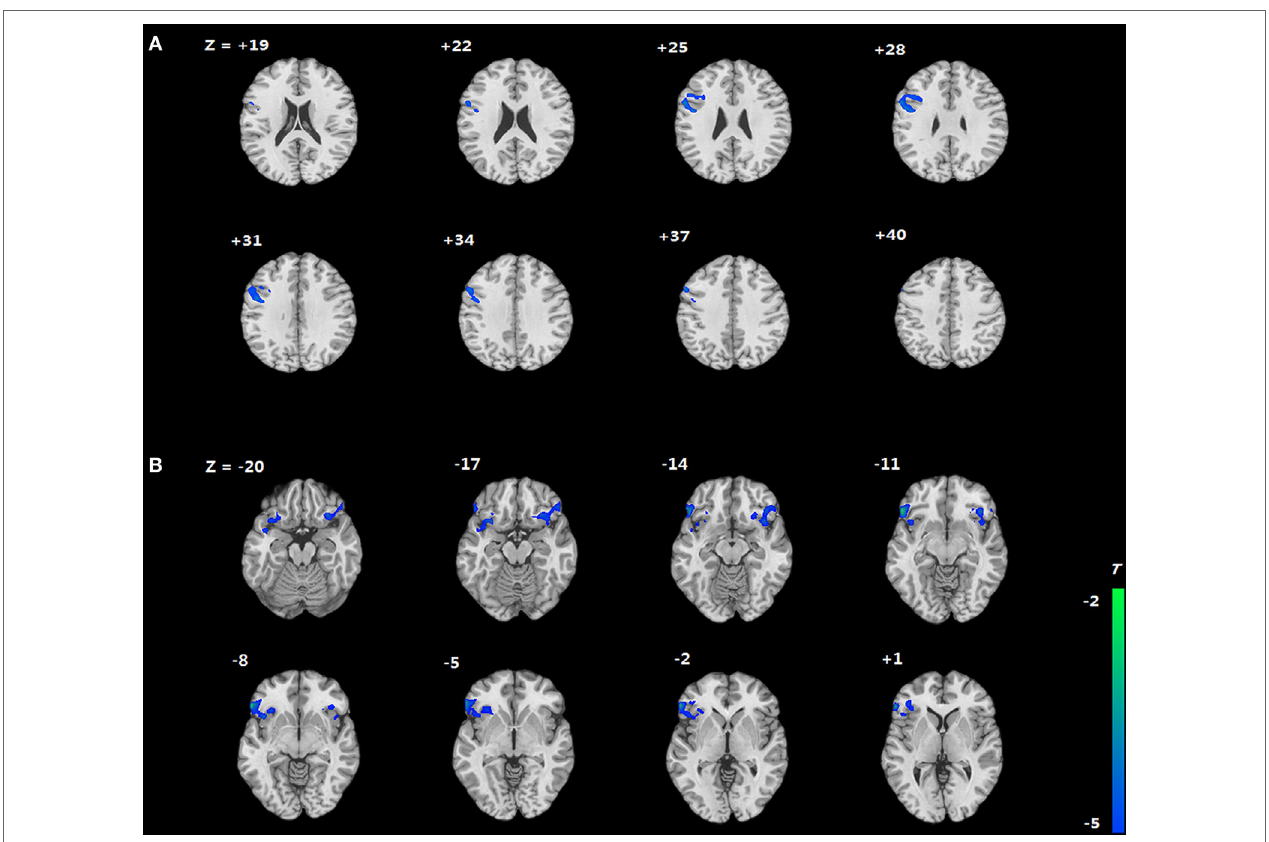
Table 2 | Brain activations change between IGD and HC (delay − immediate). region a ba x , y , z b Max t number of Inferior frontal gyrus − 54, 27, − 12 − 3.93